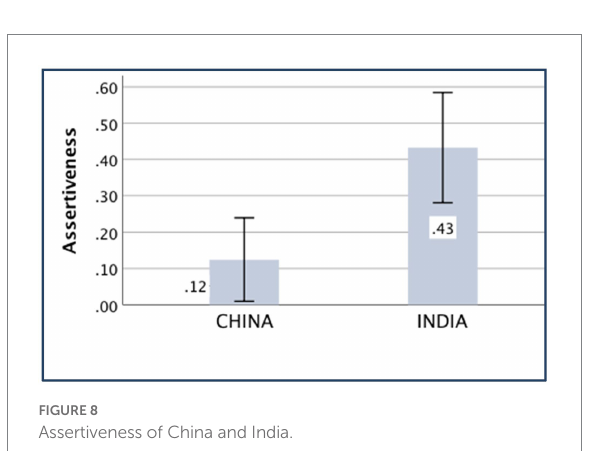
FIGURE 8 Assertiveness of China and India.